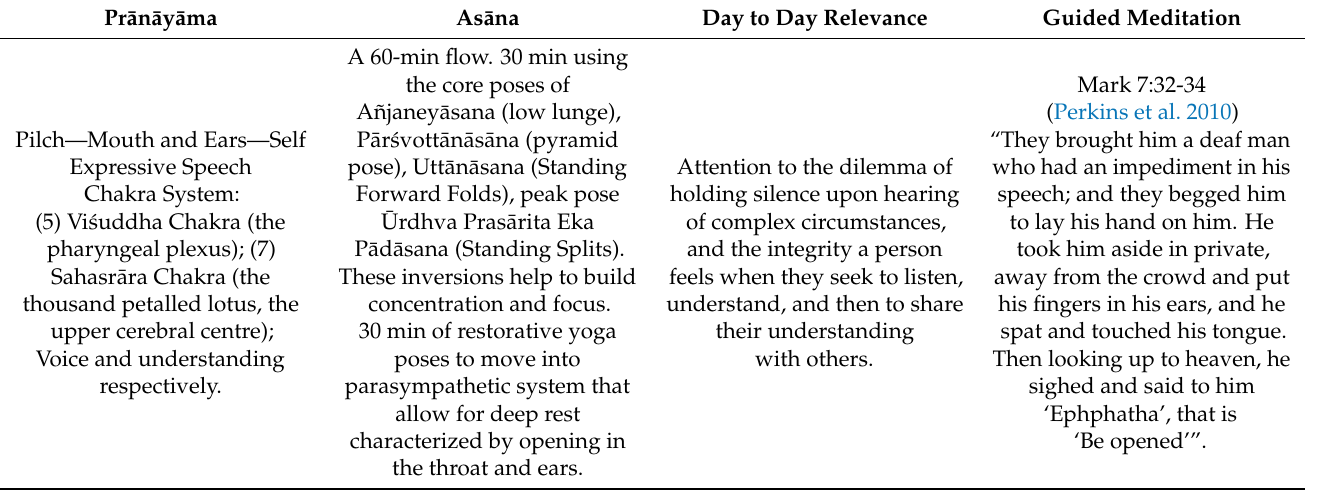
Table 3. The Patient Courage Flow—Practice